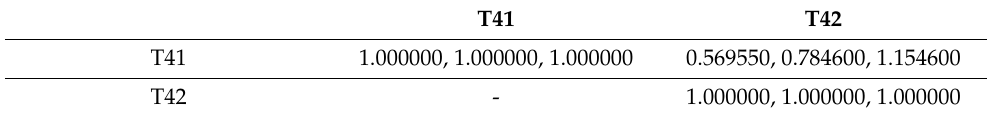
Table 5. Fuzzy aggregated pair-wise comparison matrix at level 2 for Attack Origin.